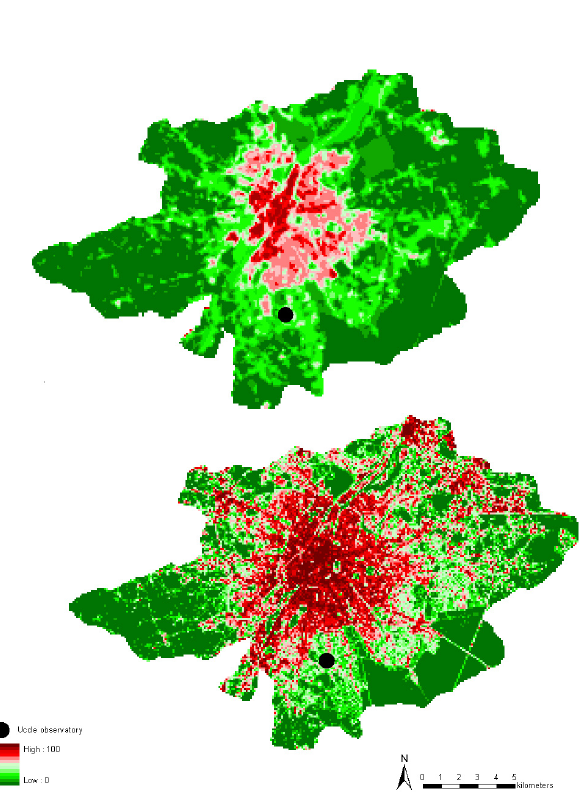
Figure 2. The percentage of impervious surfaces in the catchment basins including the Brussels Capital Region in 1955 (top) and 2006 (bottom). The black dot shows the Uccle observatory